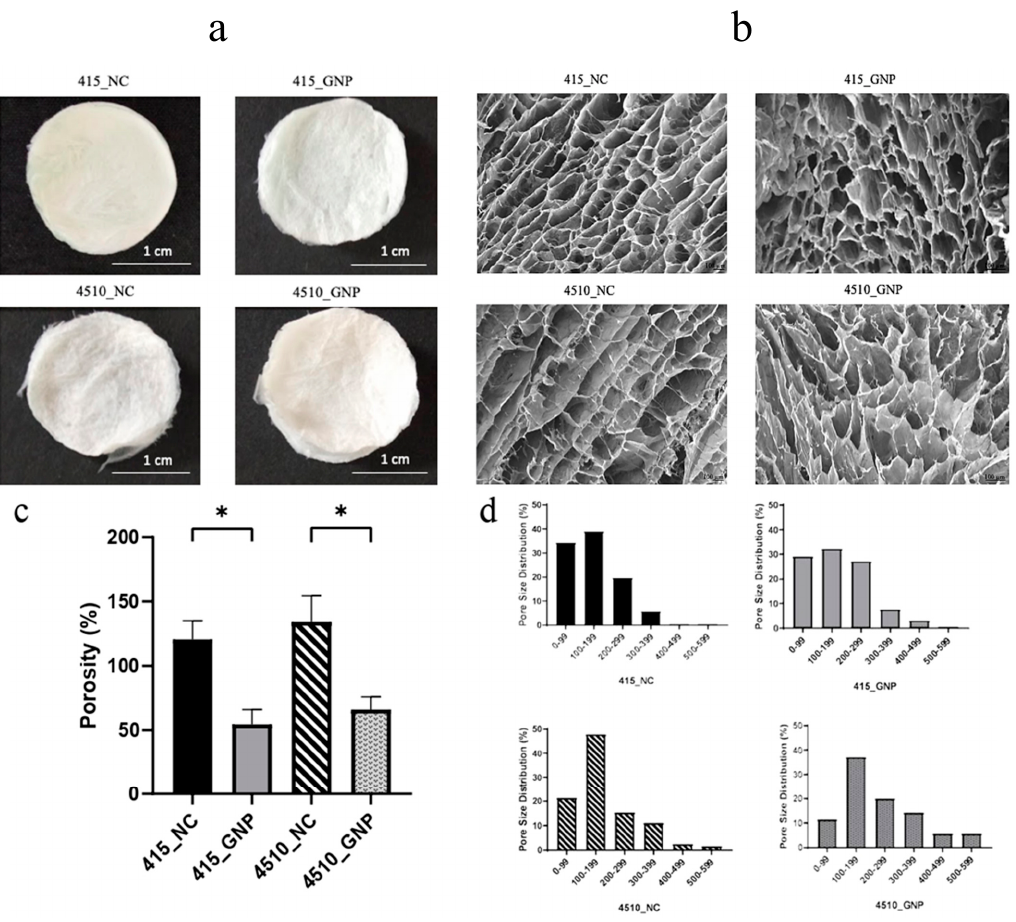
Figure 1. Effect of cross-linking on the collagen–gelatin–elastin (CollaGee) biomaterials. ( a ) Gross appearances of non-cross-linked (NC) 415 (415_NC), non-cross-linked 4510 (4510_NC), genipin (GNP) cross-linked 415 (415_GNP), and GNP cross-linked 4510 (4510_GNP). ( b ) The heterogeneous microstructure of CollaGee sponges. ( c ) Porosity of CollaGee biomaterials revealed that non-cross- linked groups had more interconnected pores than cross-linked groups. ( d ) Pore size distribution of CollaGee biomaterials indicated an acceptable pore size up to 800 µm, with 100–200 µm being dom- inant in both non-cross-linked and cross-linked groups; * p < 0.05.